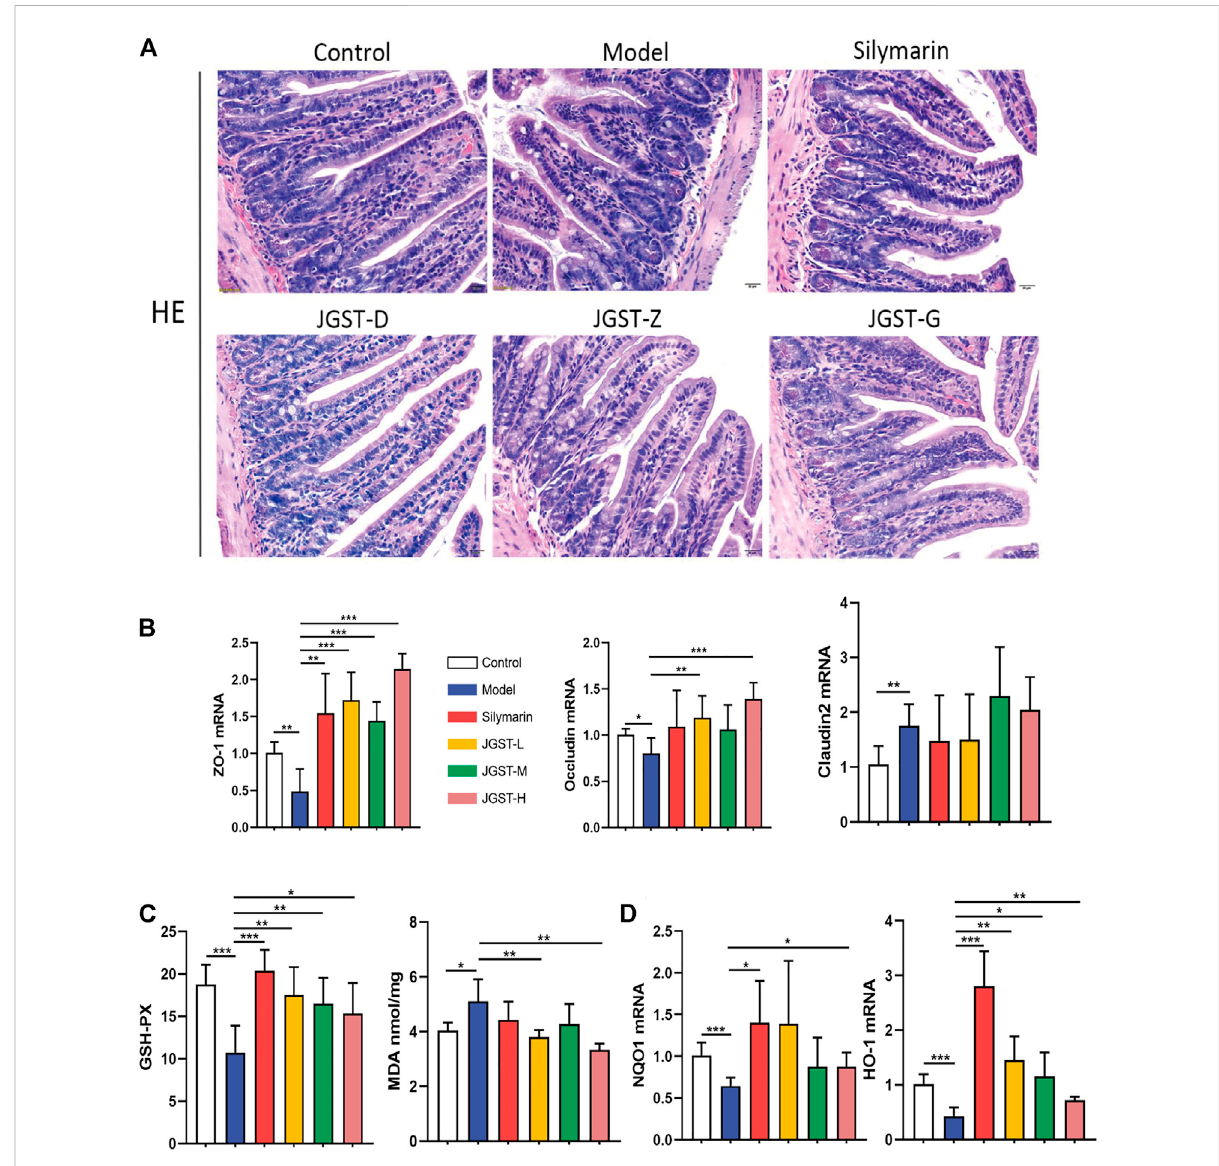
FIGURE 6 ProtectedeffectofintestinedamageofJOSTonALD. (A) RepresentativephotomicrographsofintestinetissuewithH&Estaining(x200,50p.m., n = 6). (B) mRNA expression of ZO-1, Oecludin & Claudin2 in intestine tissues. (C) Intestine level of GSH-PX, MDA. (D) mRNA expression of NQO I &HO-1 in intestine tissues. Data wcrc presented as Meant ± SEM, * p . < 0.05, ** p < 0.01, *** p < 0.001, n =